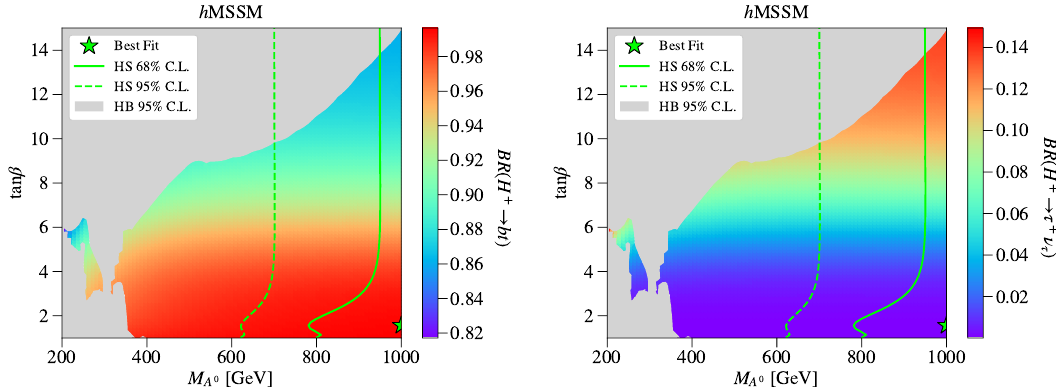
Figure 2 . Allowed regions from (cid:12)gure 1 in the ( M color representing the BRs BR( H + ! tb ) (left) and BR( H + ! (cid:28)(cid:23) )